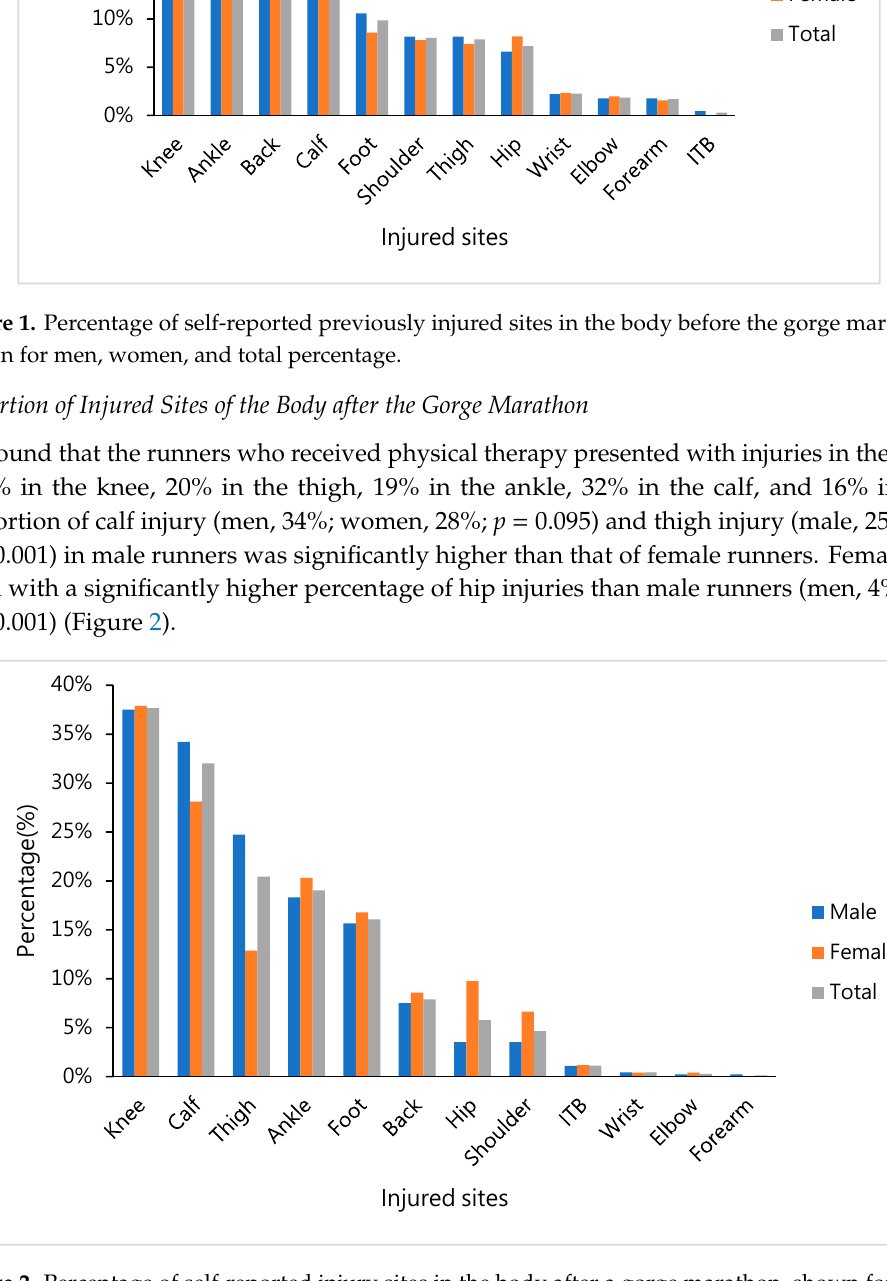
Figure 2. Percentage of self-reported injury sites in the body after a gorge marathon, shown for men, women, and total percentage.